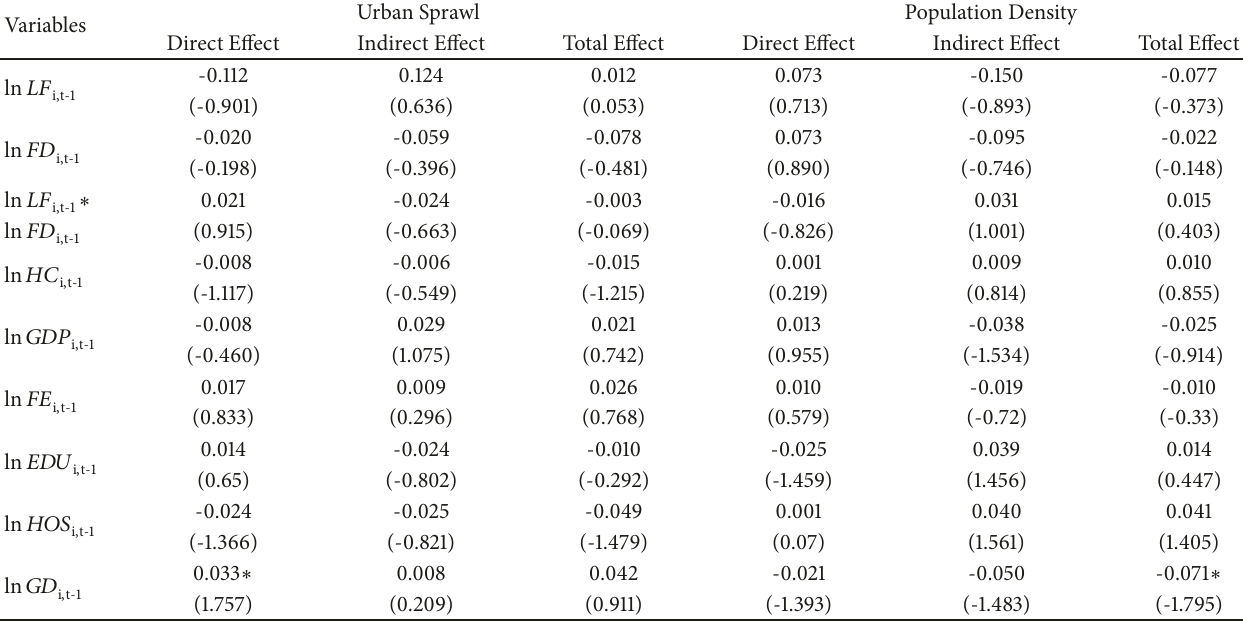
Table 6: The direct, indirect, and total effects of eastern regions.